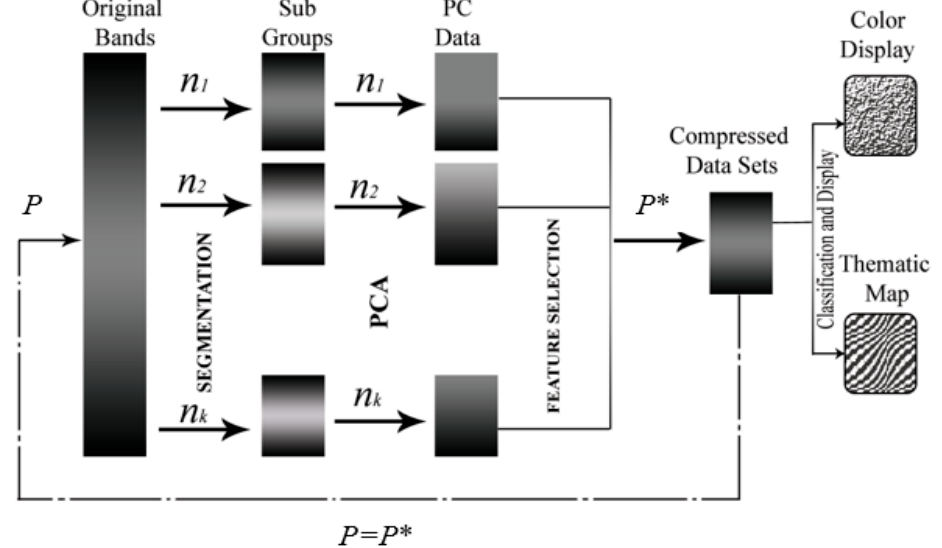
Figure 4. Working stages of BgPCA, P* denotes the number of transformed features. Algorithm 1. BgPCA